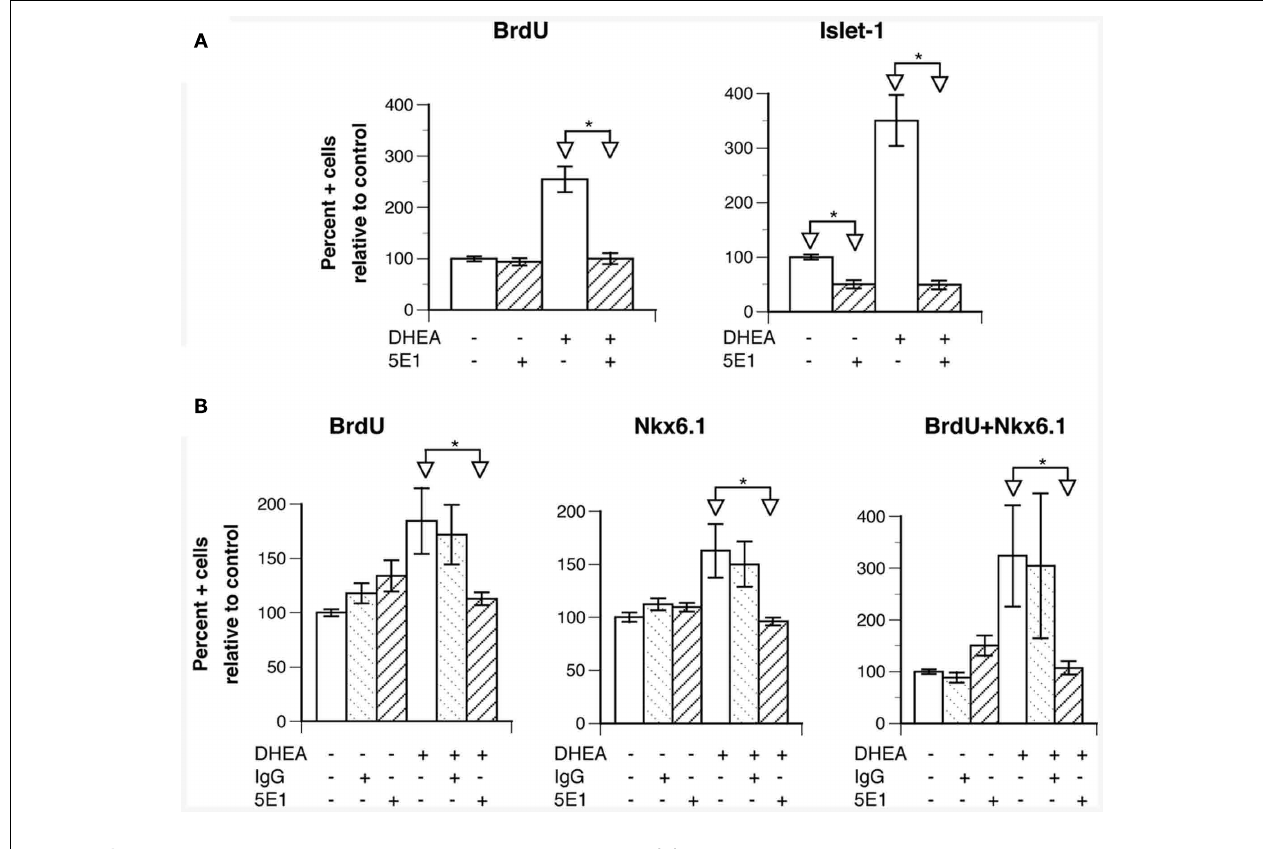
FIGURE 5 |The effects of DHEA on proliferation and neuronal differentiation are dependent upon Shh signaling. Cells isolated from E10.5 mouse neural tube lumbar region were used. (A) Effect of the addition of the anti-Shh 5E1 blocking antibody (used at 3 μ g/ml) in control and DHEA-treated cultures grown for 35h on BrdU incorporation and Isl-1 expression.The DHEA-mediated increase in BrdU incorporation and Isl-1 expression is significant in comparison to the control conditions p ≤